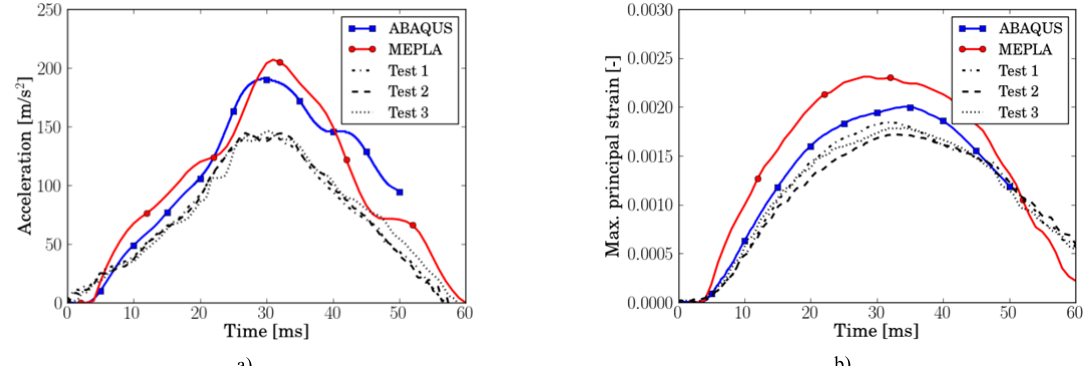
Fig. 11 Response of laminated glass upon pendulum impact at a drop height of 450 mm: a) Accelerations and b) Strain.